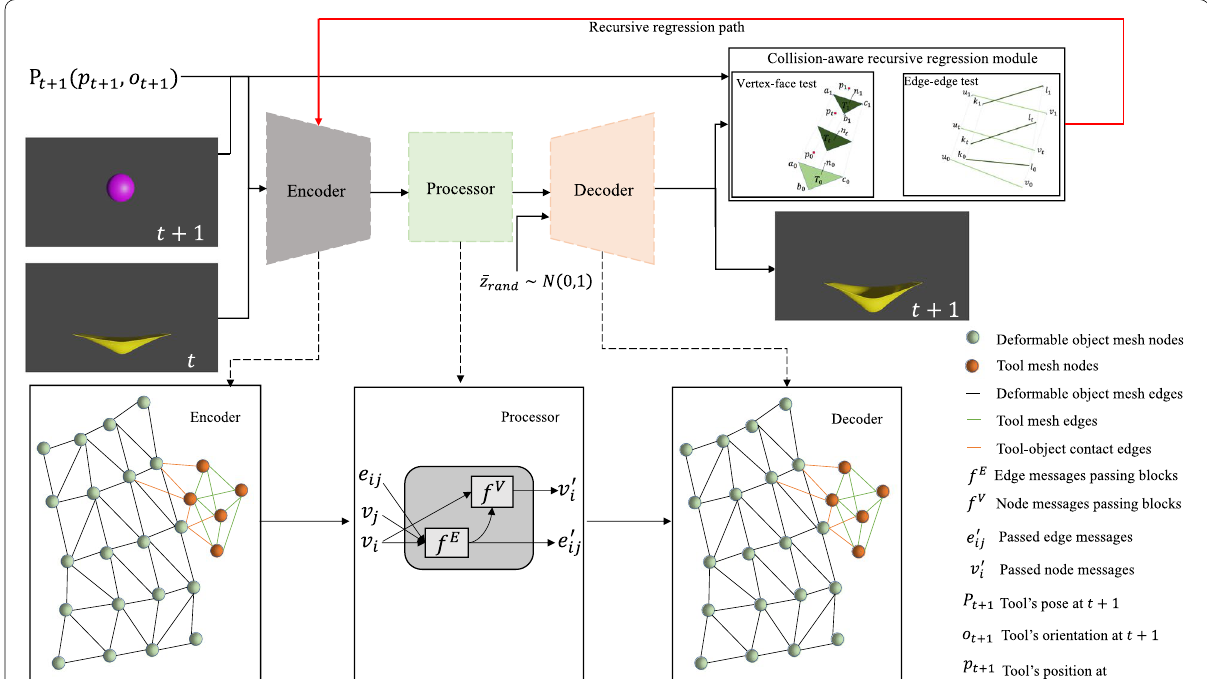
Fig. 1 Overview of the proposed method. GNN is the base model. A collision‑aware recursive regression module updates the network parameters recursively using interpenetration distances calculated from vertex‑face and edge‑edge tests. A novel self‑supervised collision term (random